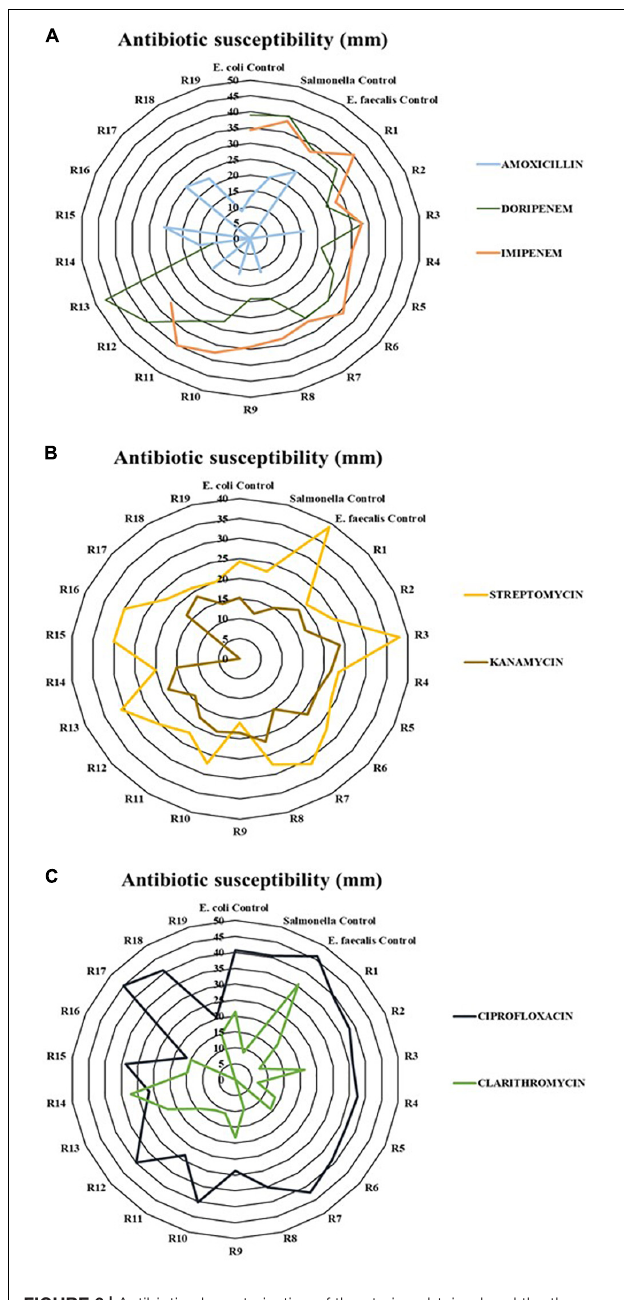
FIGURE 6 | Antibiotic characterization of the strains obtained and the three controls used ( E. coli ATCC 13706; Salmonella ATCC 10708; E. faecalis ATCC 33186). Panel (A) represents beta-lactam antibiotics; Panel (B) represents aminoglycoside antibiotics; and Panel (C) represents quinolone and macrolide